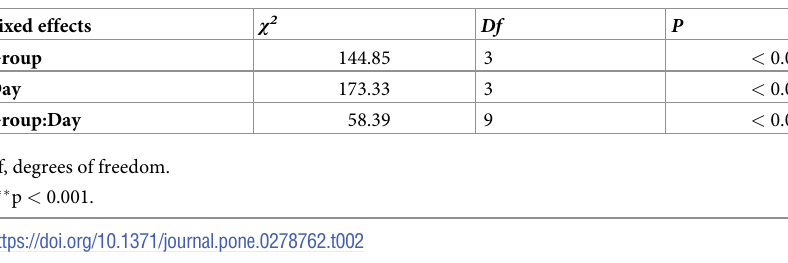
Table 2. Wald χ 2 test results in the GLMM for Groups and Days.